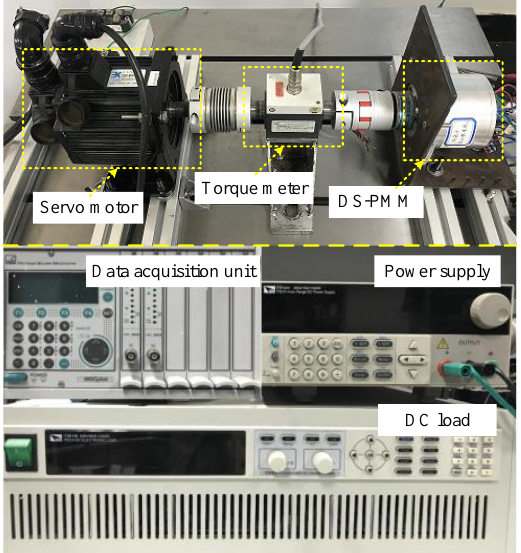
Figure 7. The test rig of the WS control strategy for the investigated DS-PMM.